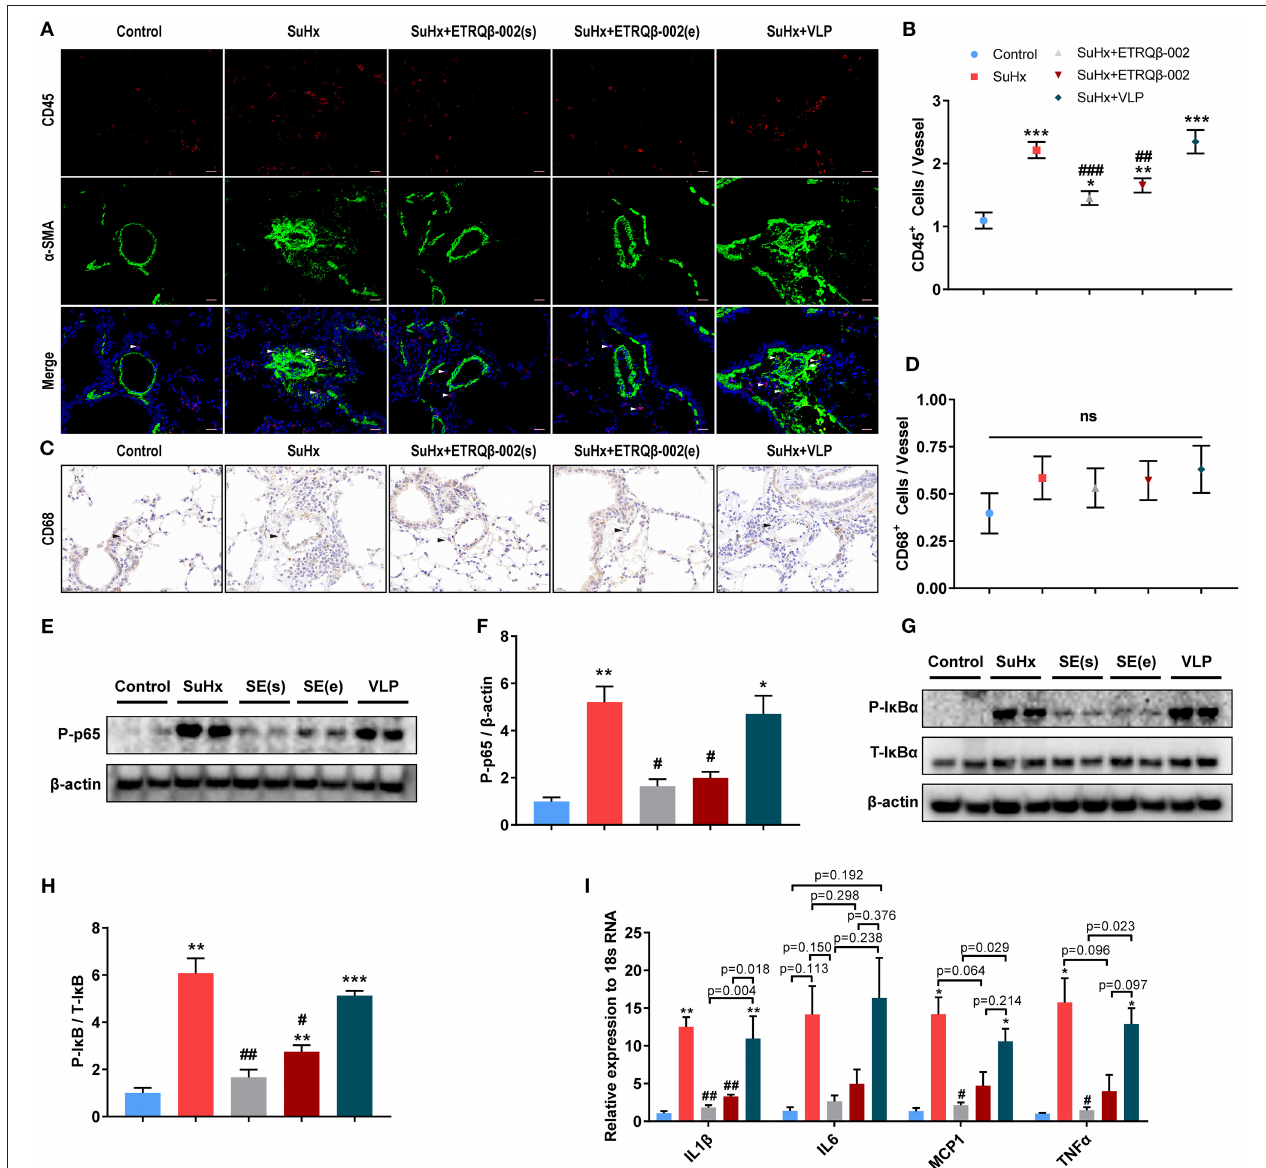
FIGURE 3 | ETRQ β -002 vaccine effectively reduced inflammation response of PA in SuHx-induced PAH mice. (A) Representative photographs of CD45/ α -SMA double-immunofluorescence staining of lung sections from each group (scale bar = 20 µ m). (B) The number of CD45-positive cells in vessels and perivascular tissues ( n = 5). (C) Representative photographs of CD68 immunohistochemistry staining of lung sections from each group (scale bar = 20 µ m). (D) The number of CD68-positive cells in vessels and perivascular tissues ( n = 5). (E,F) Representative immunoblot, corresponding densitometric analysis of pI κ B and total I κ B ( n = 6). (G,H) Representative immunoblot, corresponding densitometric analysis of pp65 and total p65 ( n = 6). (I) Quantitative RT-PCR (qRT-PCR) analysis of proinflammatory factors in lung homogenate from five groups ( n = 4–5). The white and black arrows refer to the CD45-positive cells and the PAs, respectively. All data are expressed as the mean ± SEM. * P < 0.05, ** P < 0.01, *** P < 0.001 vs. the control group. # P < 0.05, ## P < 0.01, ### P < 0.001 vs. the SuHx group. ns, no significant